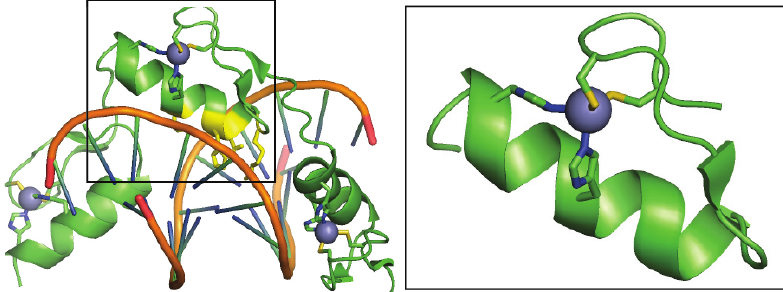
Figure 2. Three zinc fingers motifs bound within the major groove of a DNA strand with a single zinc finger motif being highlighted (black box). Zn 2+ (purple) is bound to two cysteine and two histidine ligands within an (cid:2)-helix and antiparallel (cid:3)-sheet. Variable sequences at the (cid:4)1, 2, 3, and 6 residues of the (cid:2)-helix (yellow) dictate preferential binding to specific nucleotide sequences. (PDB ID: